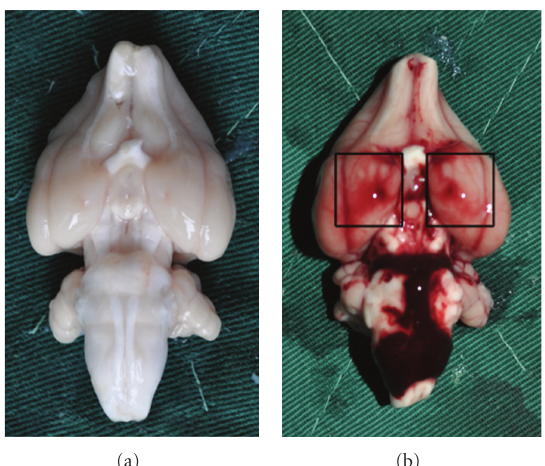
Figure 1: Representative photograph of the brain from control group (a) and day 1 SAH group (b). The brain cortex under the pane is the sample to be detected. It showed that blood clots mainly located in inferior temporal lobe and around the basilar arteries.